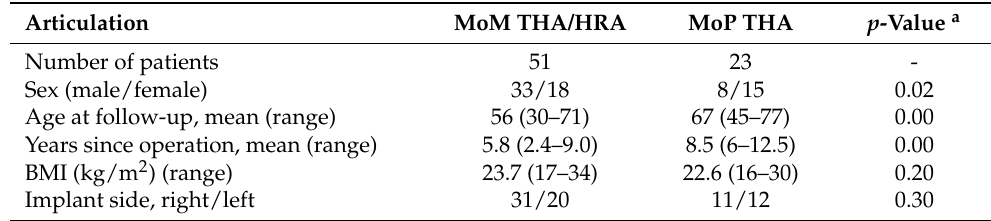
Figure 1. Flowchart of included patients and articulation types and sizes. Table 1. Baseline characteristics of patients with metal-on-metal (MoM) total hip articulation (THA)/hip resurfacing articulation (HRA) and metal-on-polyethylene (MoP) THA.